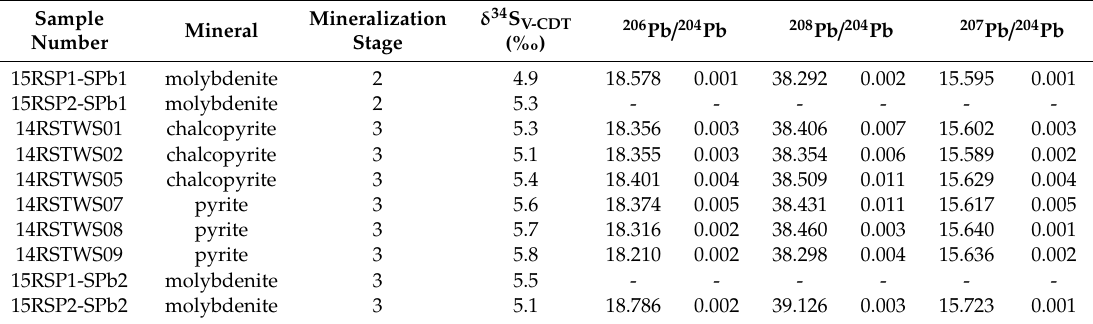
Table 2. Sulfur and lead isotopic compositions of sulfides from the Reshui Mo